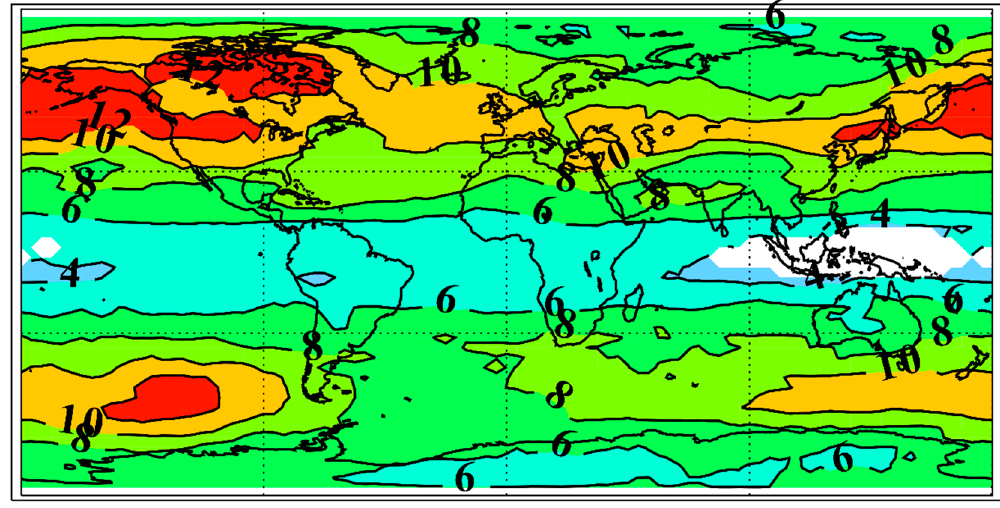
Figure 9. Geographical distribution of the annual mean total column ozone trend (DU / 31 years) during .